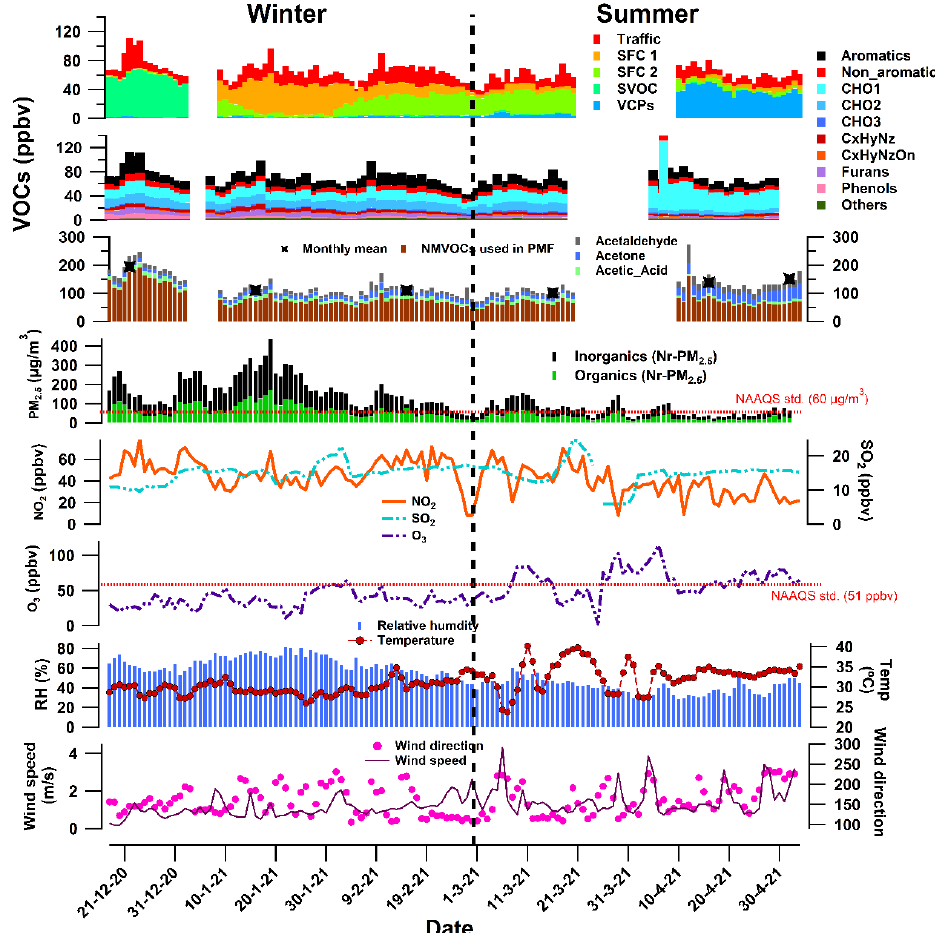
Figure 3. Daily averaged time series of acetaldehyde, acetone, and acetic acid, other NMVOCs, PM 2 . 5 and its organic fraction, NO 2 , SO 2 , O 3 , temperature, relative humidity, and wind speed and